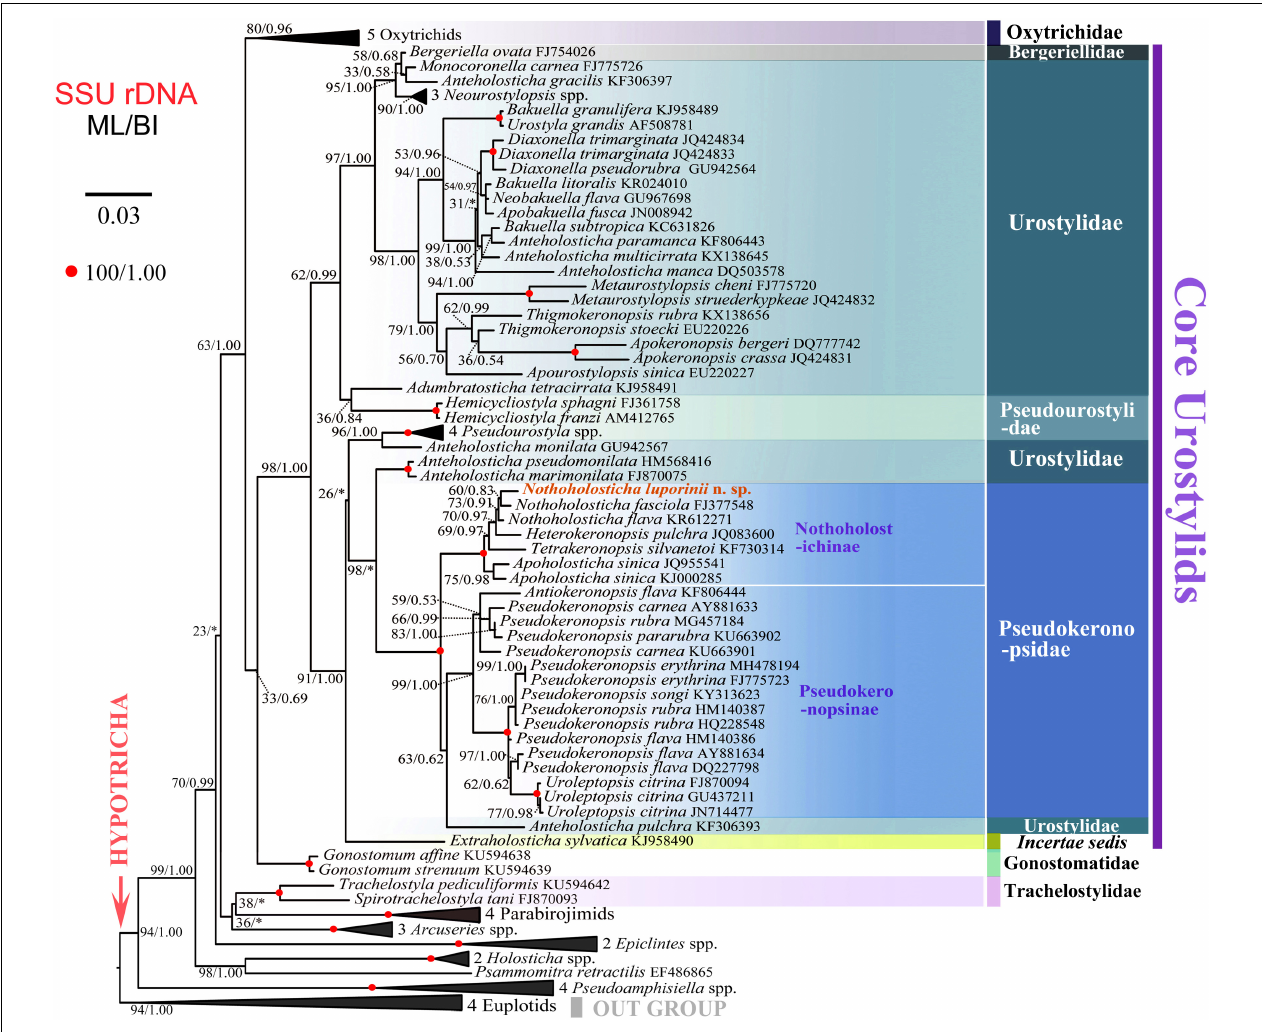
FIGURE 7 | Maximum likelihood tree inferred from SSU rDNA sequences, showing the systematic position of Nothoholosticha luporinii n. sp. (indicated in red). Numbers near branches denote bootstrap values for maximum likelihood (ML) and posterior probabilities for Bayesian inference (BI). Asterisk indicates the disagreement between ML and BI trees. GenBank accession numbers are provided after species names. For taxon sampling and GenBank accession numbers in the collapsed clades, see Supplementary Table S1 . Scale bar corresponds to three substitutions per 100 nucleotide positions.